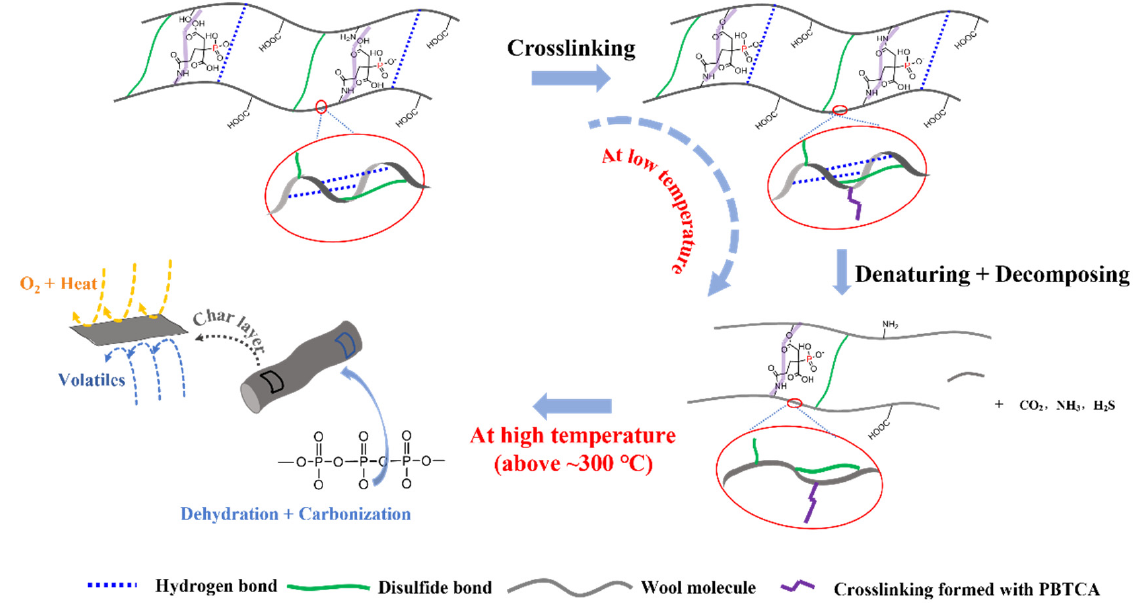
Figure 10. Flame-retardant mechanism of the PBTCA-treated wool at low and high temperature.